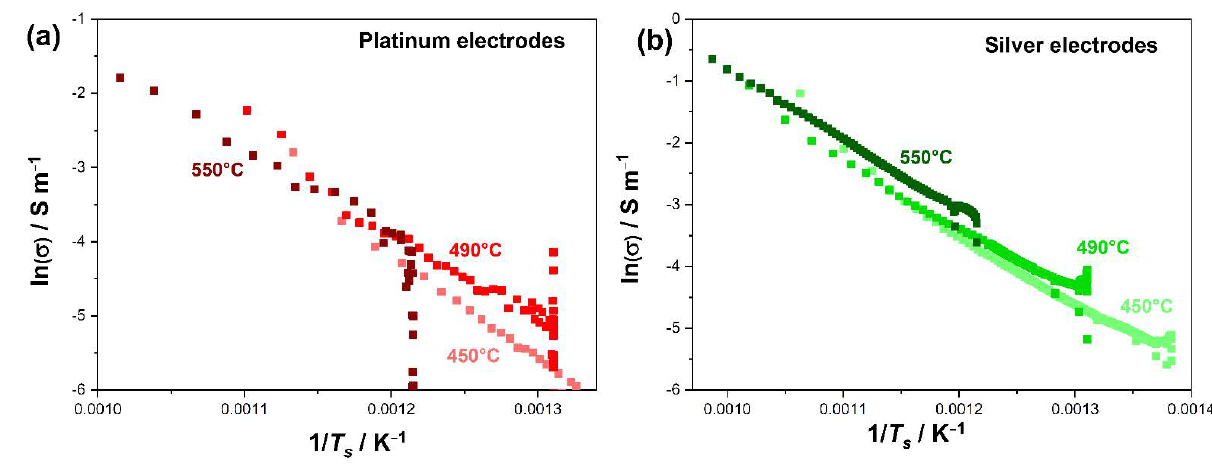
Figure 4. The logarithm of conductivity as a function of the estimated sample temperature for ( a ) Pt-plated and ( b ) Ag-plated samples.